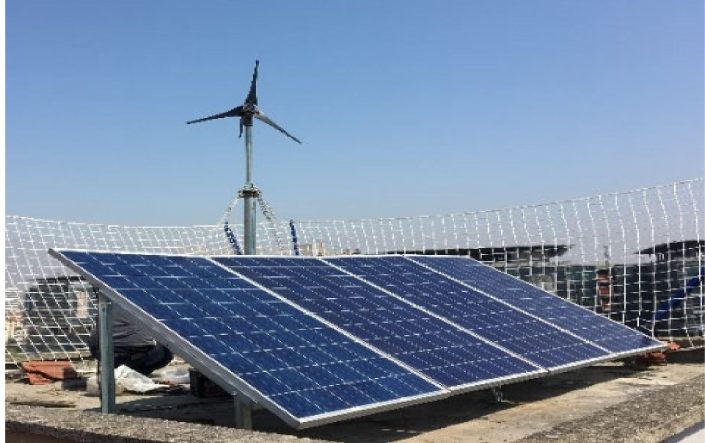
Figure 2. Wind turbine and PV modules on the rooftop of the faculty building.